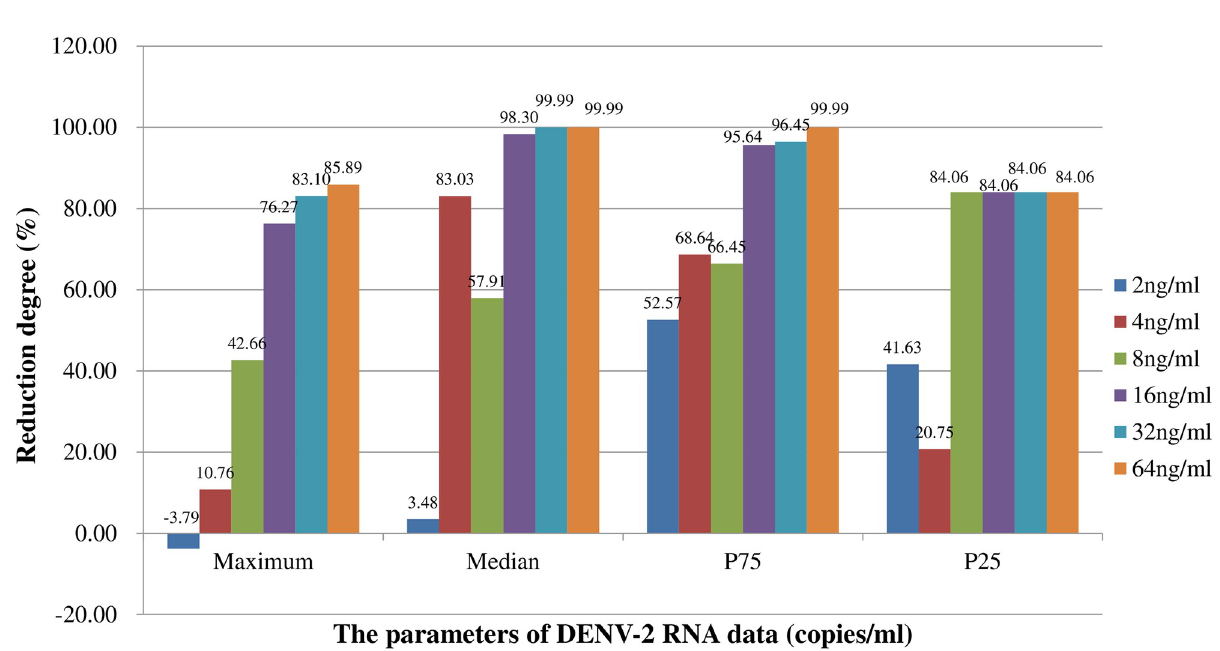
Fig 3. Compare to mosquitoes fed with 0ng/ml ivermectin, the reduction degree of maximum, median, P 75 , P 25 of DENV-2 RNA concentration for each treatment group. The calculation formula is as follows: (parameter (e.g. median) in mosquitoes fed with 0ng/ml ivermectin-parameter in each treatment group)/ parameter in mosquitoes fed with 0ng/ml ivermectin � 100%.